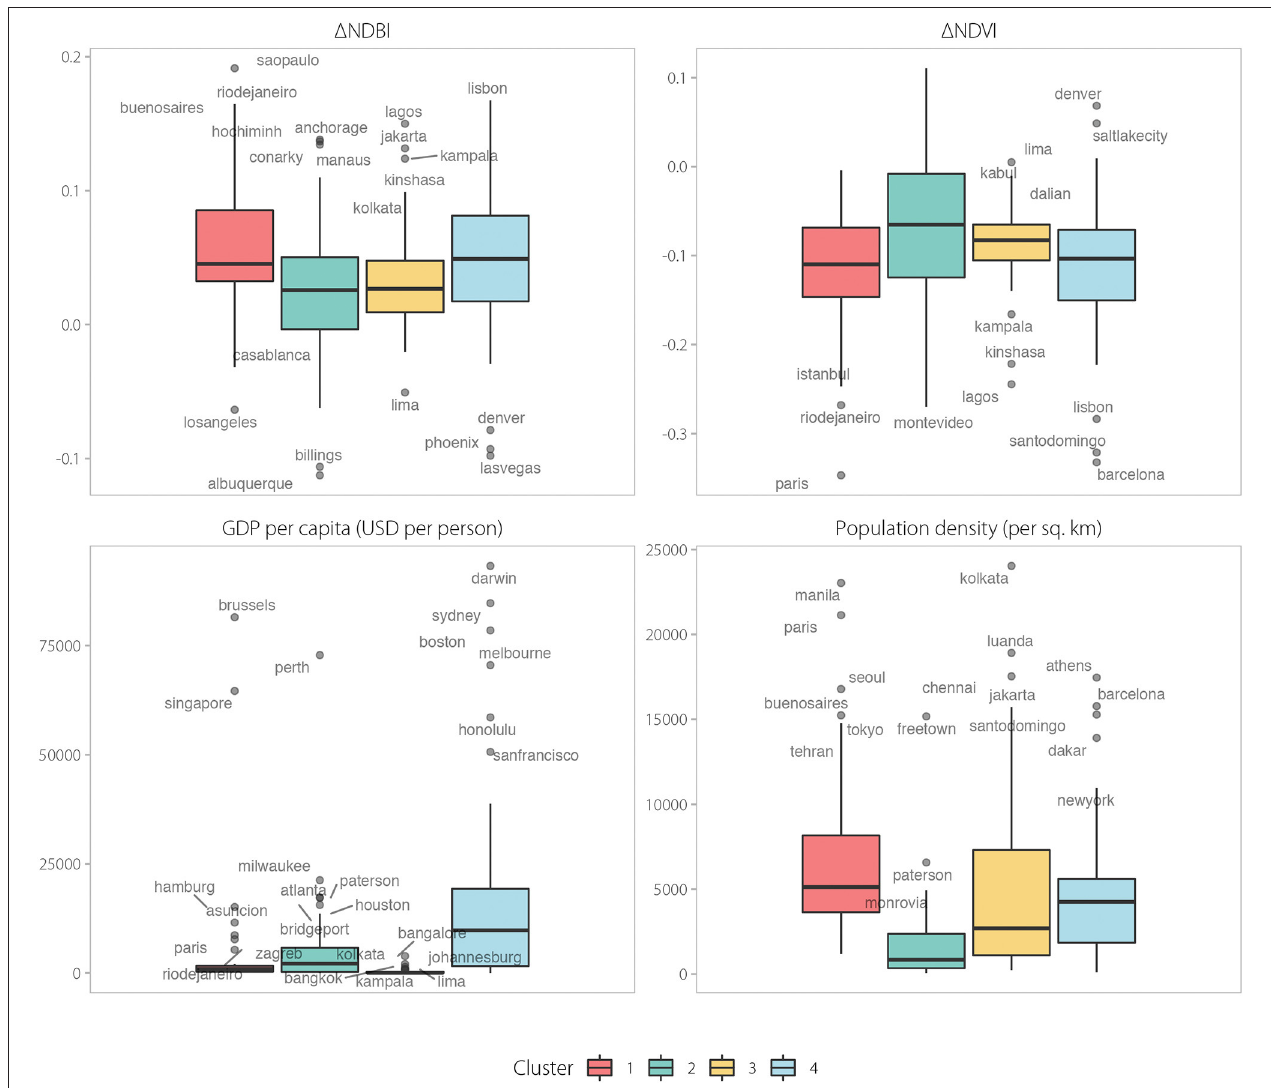
FIGURE 7 | Boxplot showing the distribution of mean GDP per capita and morphological characteristics such as 1 NDBI (built-up index), 1 NDVI (greenness index), and population density per sq.